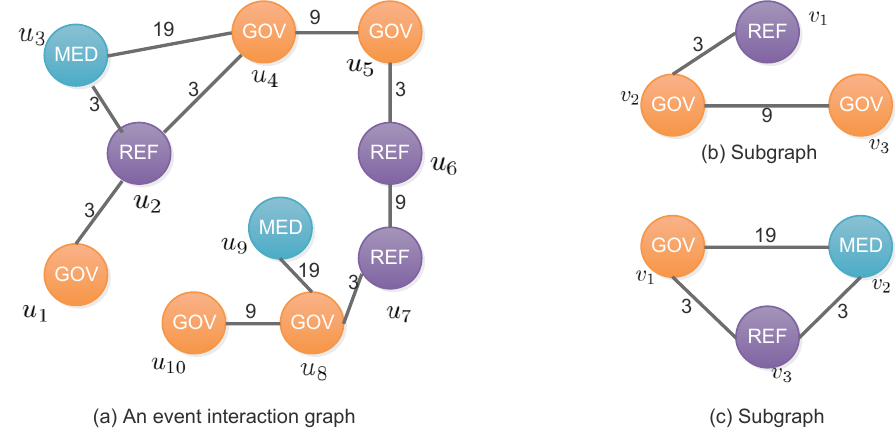
Figure 1. ( a ) An event interaction graph; nodes represent the event actors (labelled with their type code) and edges represent the event (labelled with event type code); and ( b , c ) two subgraphs of ( a ) (MED: Media, REF: Refugee, GOV: